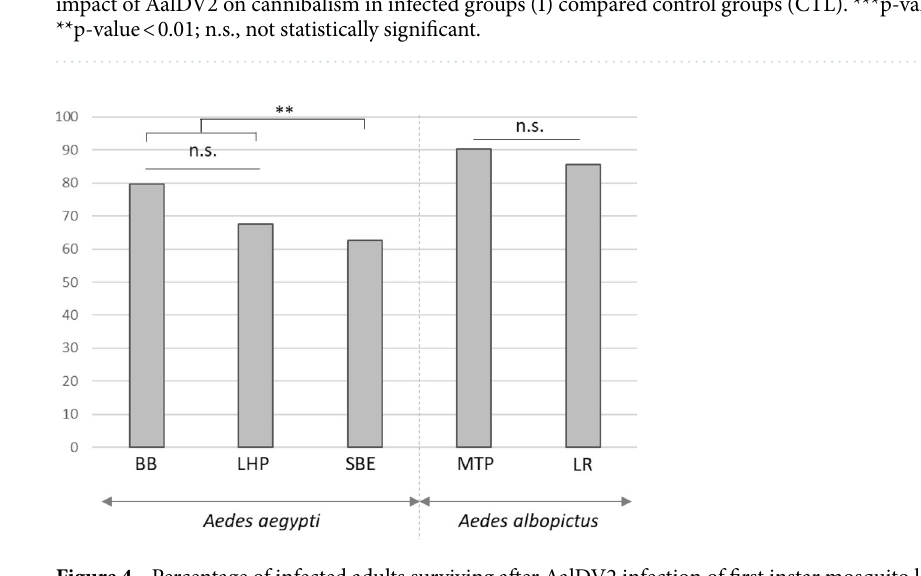
Figure 4. Percentage of infected adults surviving after AalDV2 infection of first instar mosquito larvae for the different strains tested of Ae. albopictus (MTP, Montpellier and LR, La Réunion) and Ae . aegypti (LHP, Long- Hoà, BB, Bora-Bora and SBE, Benin). Larvae (N = 3 replicates of 150 larvae per experimental condition) were infected or not, with 3 × 10 11 veg/ml of AalDV2. Binomial linear mixed effect models were used to compared the impact of AalDV2 in different strains. **p-value < 0.01; n.s., not statistically